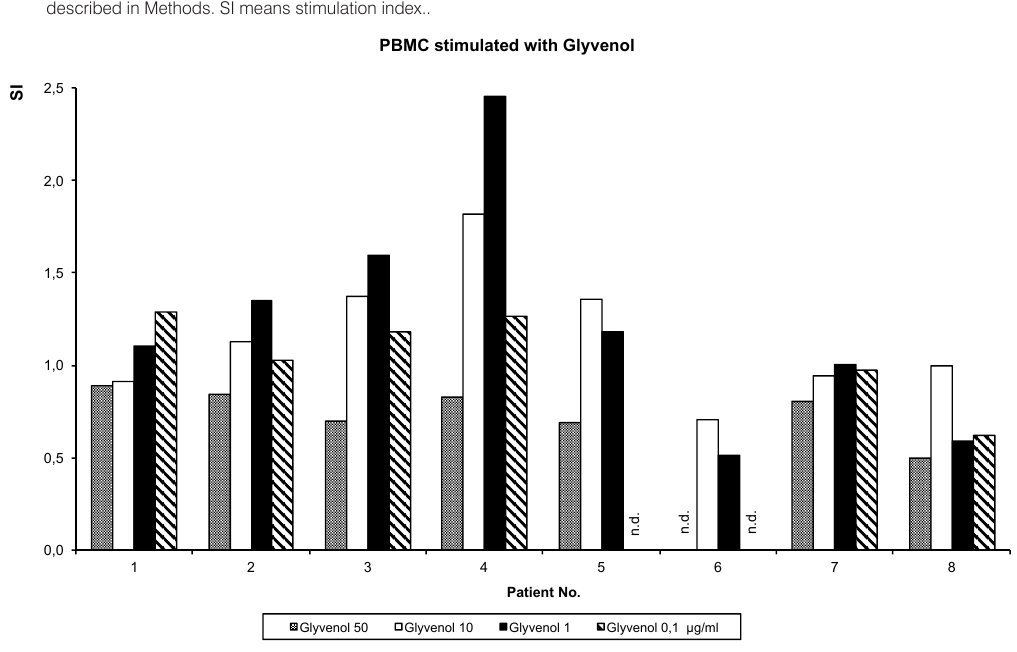
Figure 5. Results of LTT. Peripheral blood mononuclear cells (PBMC) stimulated with Glyvenol. The culture is measured in triplicates as described in Methods. SI means stimulation